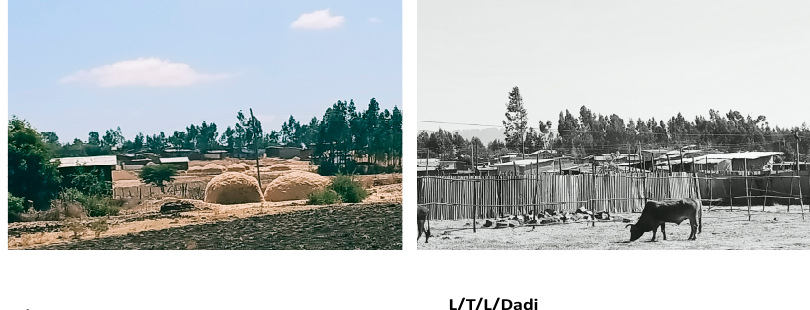
Figure 7. The expansion of informal settlements; Lega Tafo Lega Dadi and Gelan, 2022.